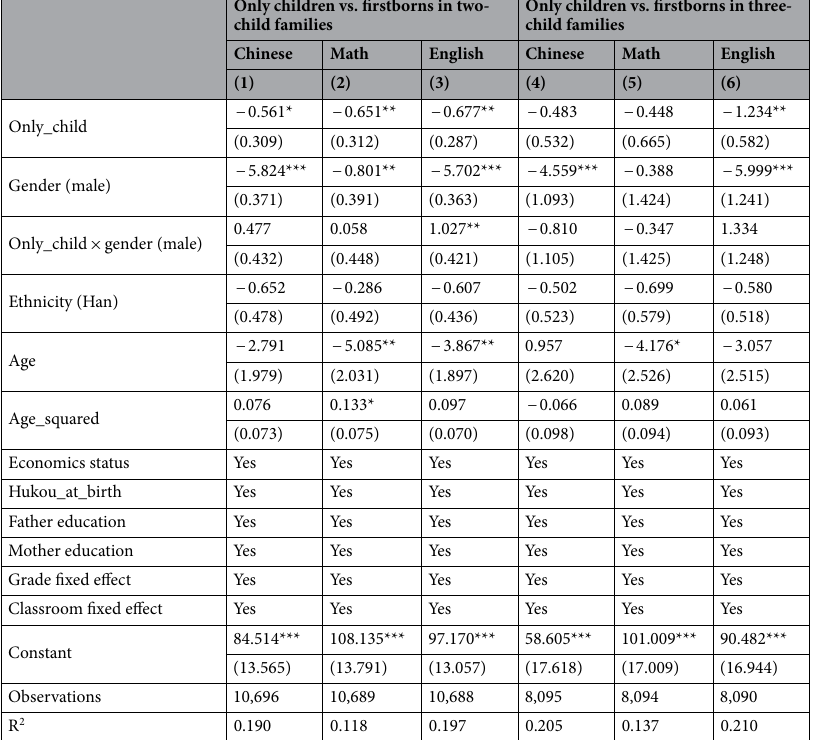
Table 5. The comparison of educational outcomes between only children and firstborns in two-child/three- child families by genders. Notes: Standard errors in parentheses, adjusted for within-classroom clustering. * p < 0.10. ** p < 0.05. *** p <